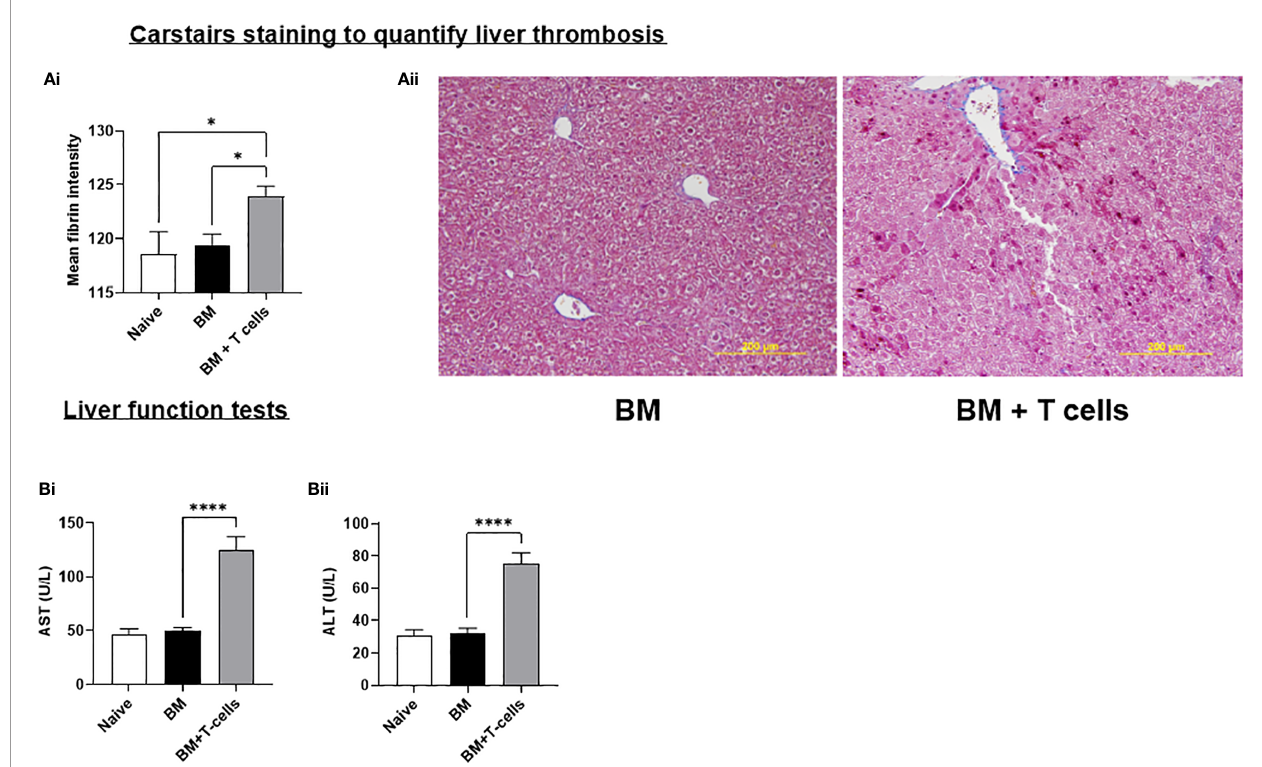
FIGURE 5 | Hepatic SOS is evident at day 6 post-GvHD- (A) (i) Graph depicts mean intensity of Fibrin using Fiji/Image J * (ii) Representative Carstairs stain images show liver sections, sectioned at 4µm where blue depicts collagen, dark red- Fibrin and yellow-red blood cells. (B) Liver Function Test shows increased levels of (i) aspartate aminotransferase (AST) and (ii) alanine aminotransferase (ALT) which is commonly associated with SOS. *p < 0.05, ****p < 0.00005, n=6 naïve; n=13 BM and BM+T cells. Data is densitometric quanti fi cation relative to actin; Mean ± SEM. One-Way ANOVA, Tukeys post hoc